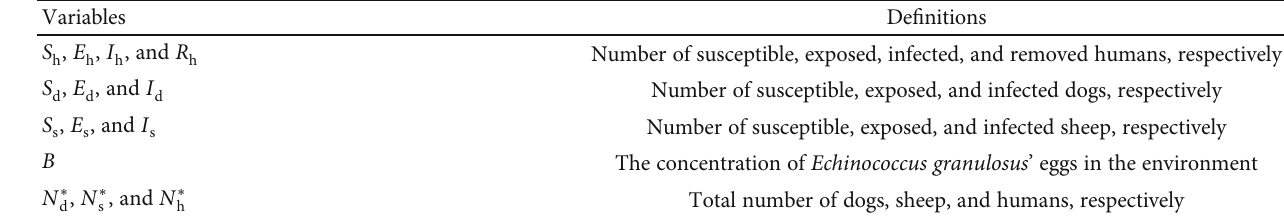
Table 1: De fi nitions of variables.